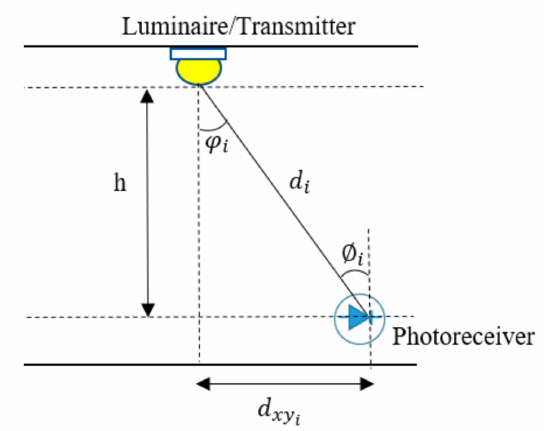
Figure 14. VLP system depicting the parameters of Lambertian propagation